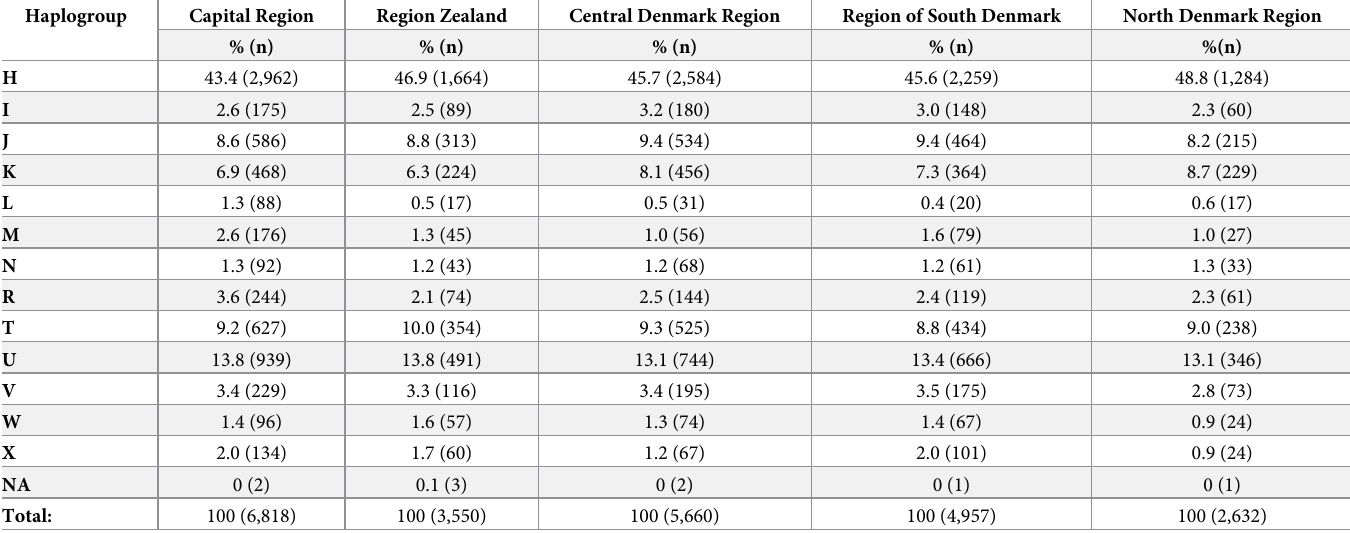
Table 5. Distribution of the most frequent haplogroups in the five administrative regions of Denmark. Only persons born at locations with � 20 births are included.